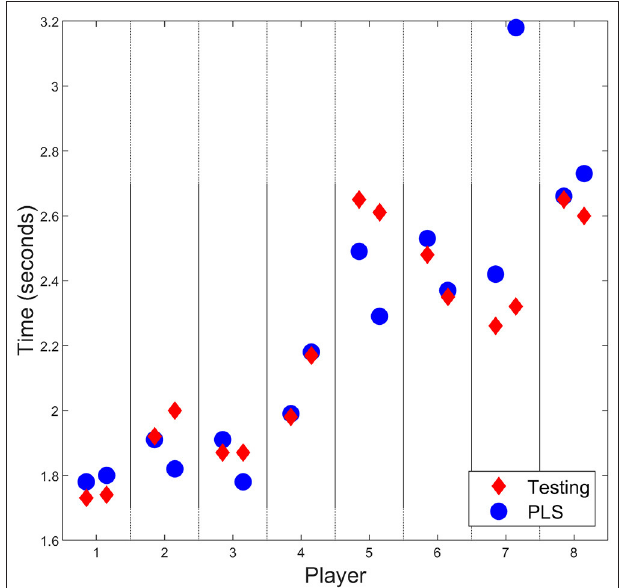
FIGURE 4 | Comparison of sprint times from testing and the regression approach for all players. Most predictions follow the testing data closely, with largest differences seen in Players 5 and